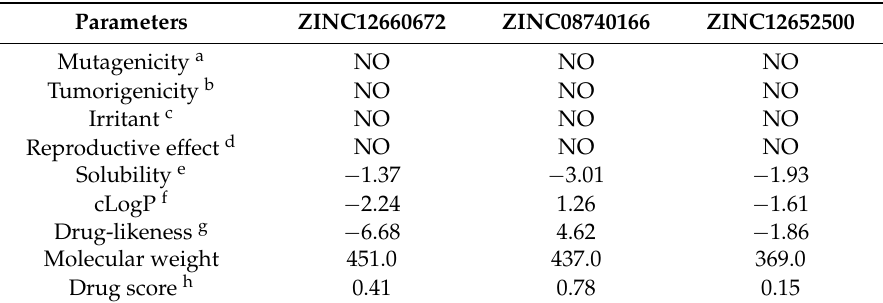
Table 3. In silico pharmacokinetic and toxicity prediction study of ZINC12660672, ZINC08740166 and